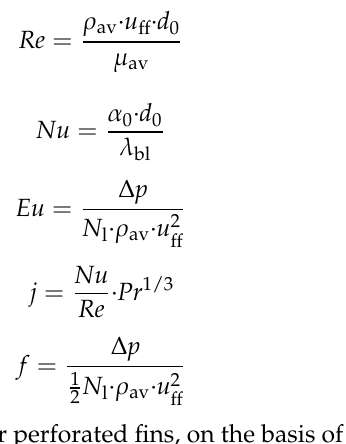
Figure 9. Dimensionless wall distance y + .